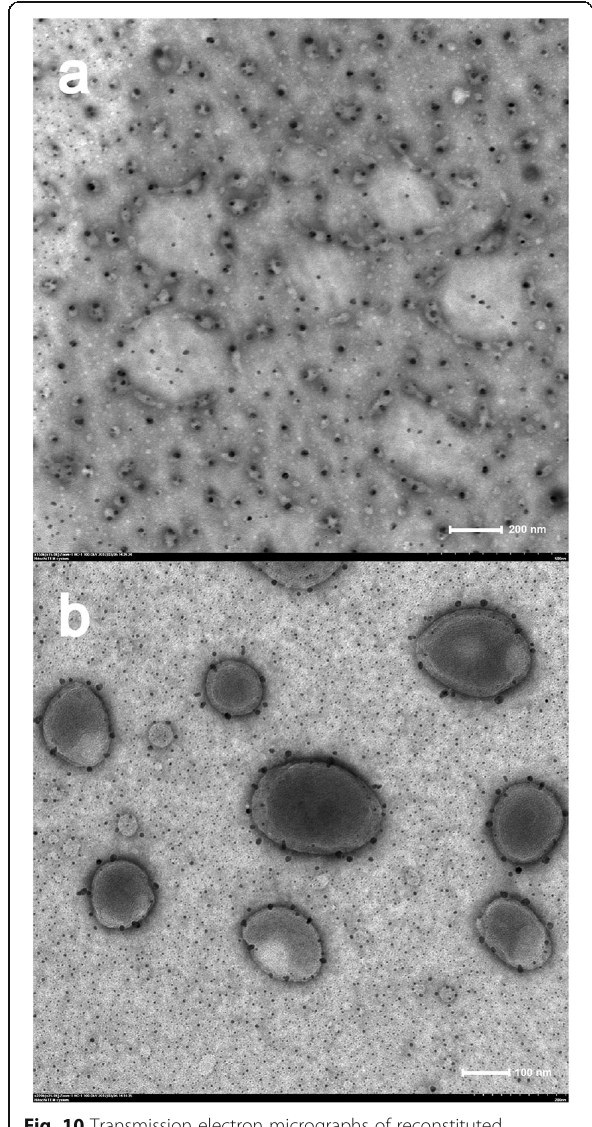
Fig. 10 Transmission electron micrographs of reconstituted liposomes, ( a ) initial state of hydration of proliposomes, ( b ) fully assembled liposomes